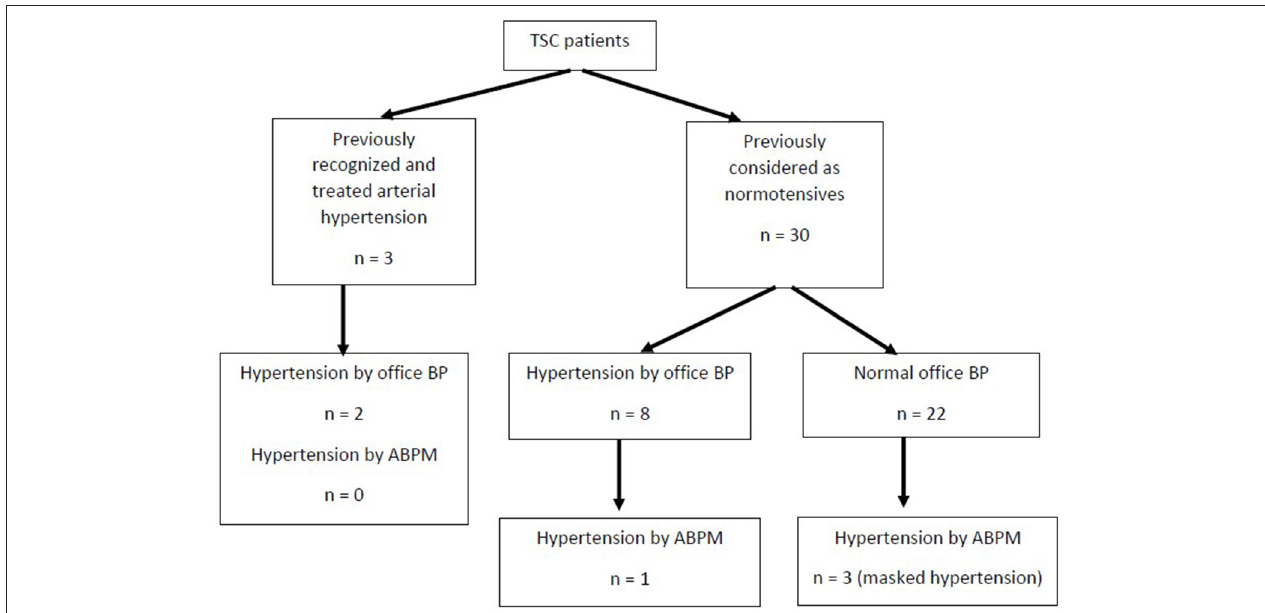
FIGURE 3 | The results of blood pressure measurement in children with tuberous sclerosis complex (TSC, tuberous sclerosis complex; BP, blood pressure; ABPM, ambulatory blood pressure monitoring).